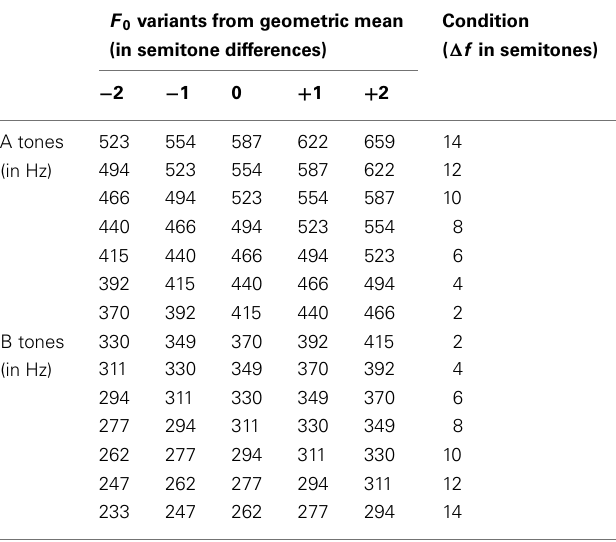
Table 1 | Fundamental frequencies ( F 0 ) of the tone complexes and their assignment toA and B